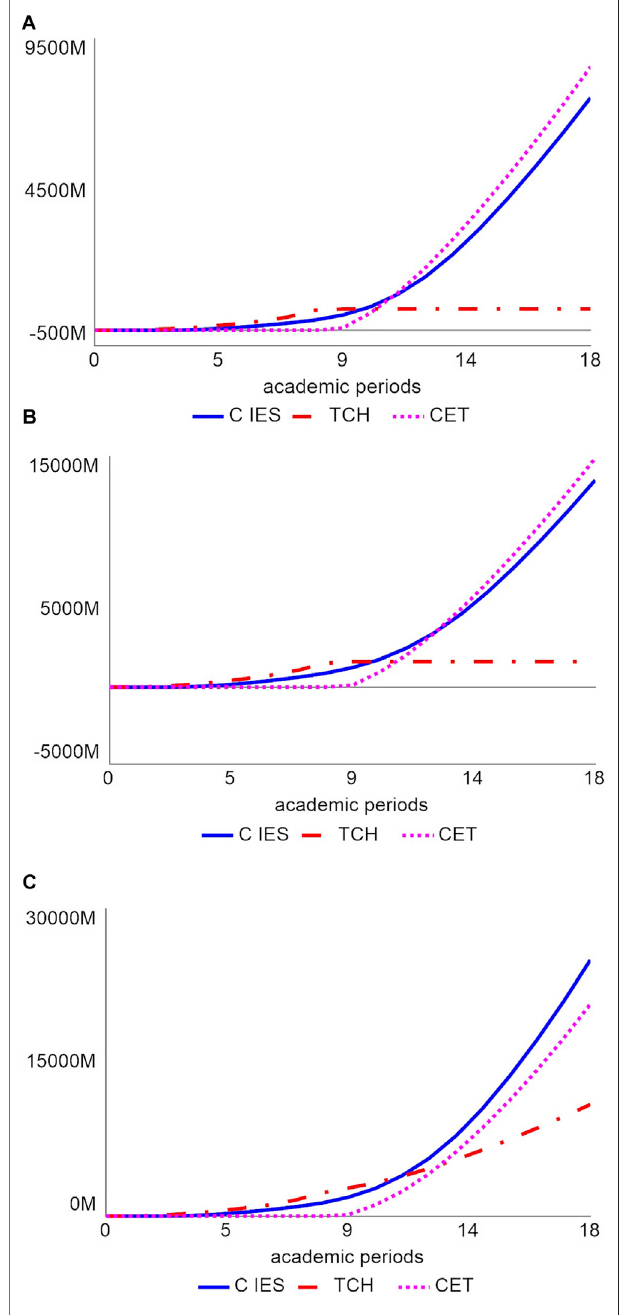
FIGURE 7 | Behaviour of the economic effects of drop-out for SIM-3. Note: (A) presents technical training programmes, (B) technological training and (C) professional training. C IES: Total cost for the training programmes under study per t . THC: Stranded cost for the family per t . CET: Total cost for the State per t